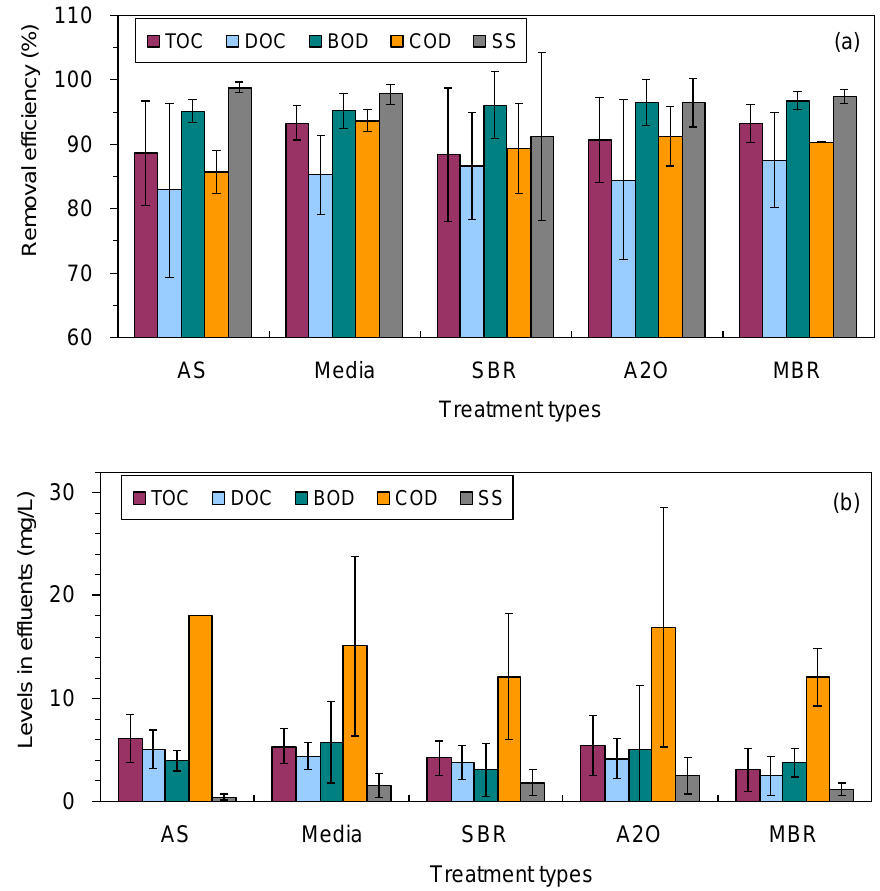
Figure 1. ( a ) Removal efficiencies of TOC, DOC, BOD, COD and SS using different types of wastwater treatments; and ( b ) The levels of TOC, DOC, BOD, COD and SS in the effluents from different types of wastwater treatment